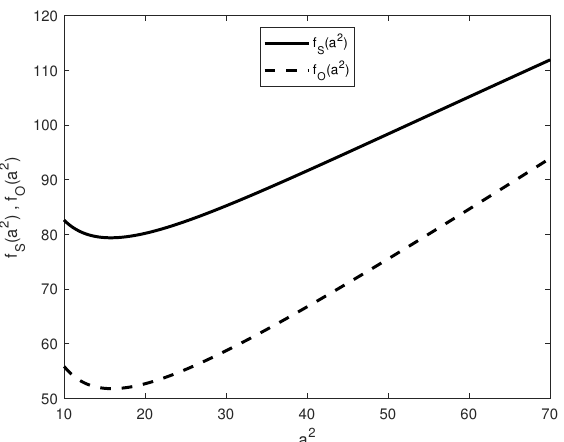
Figure 5. Behaviour of f s ( a 2 ) and f o ( a 2 ) for γ = 0.8; k r = 1.5, η = 0.2, J = 1.5 and T 2 = 30.